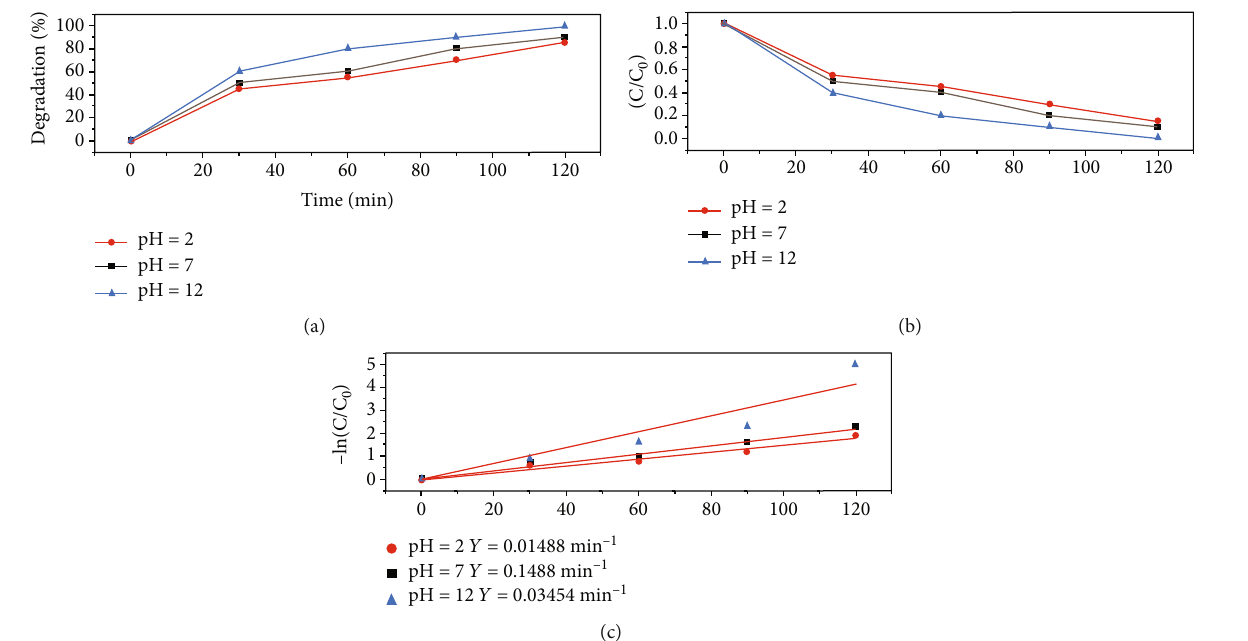
Figure 1: (a) Degradation e ffi cacy of biosynthesized TiO kinetics study of the biosynthesized TiO